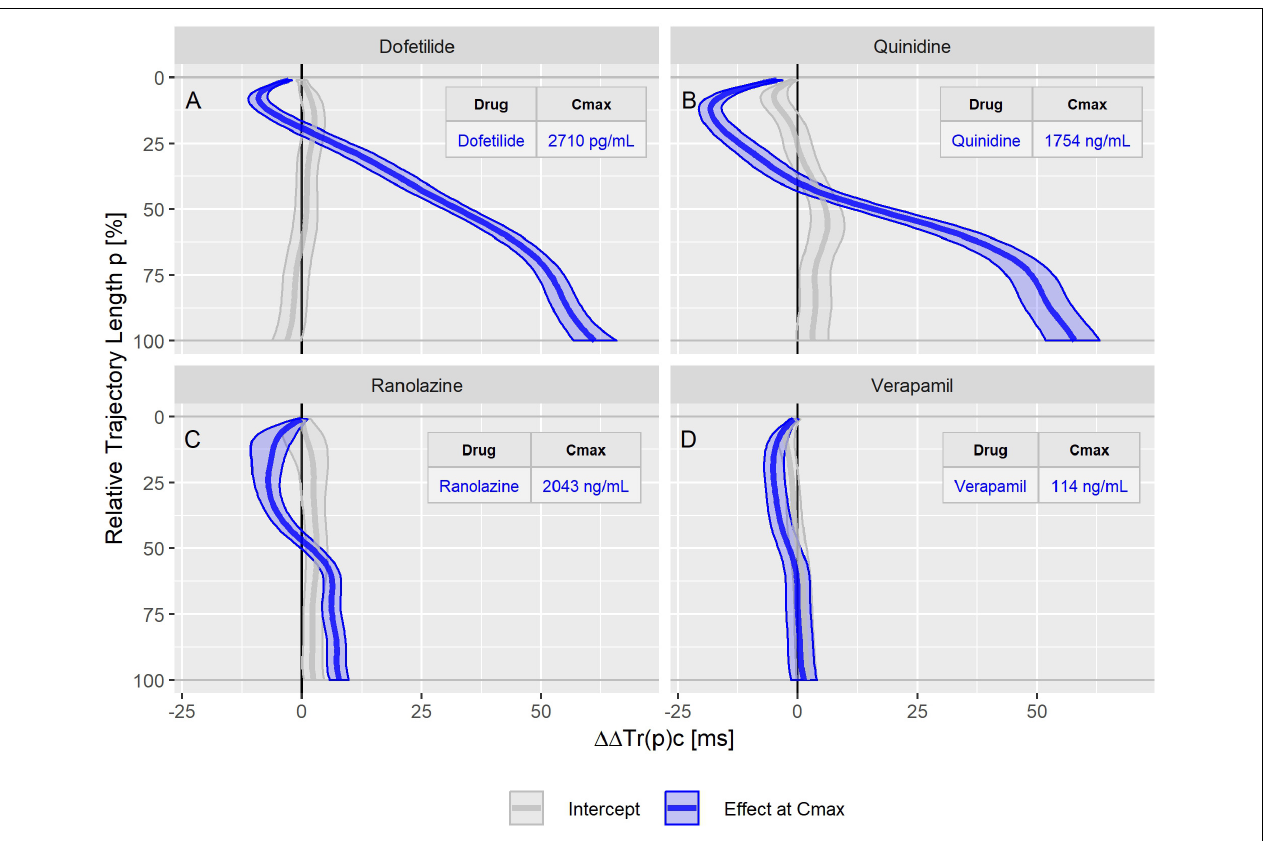
FIGURE 5 | Continuous drug effect profile estimates with 90% confidence bands for the drugs dofetilide (A) , quinidine (B) , ranolazine (C) , and verapamil (D) in study A. The blue bands denote the estimated drug effect at the drug’s maximum plasma concentration (Cmax). The gray bands are the model prediction at zero drug